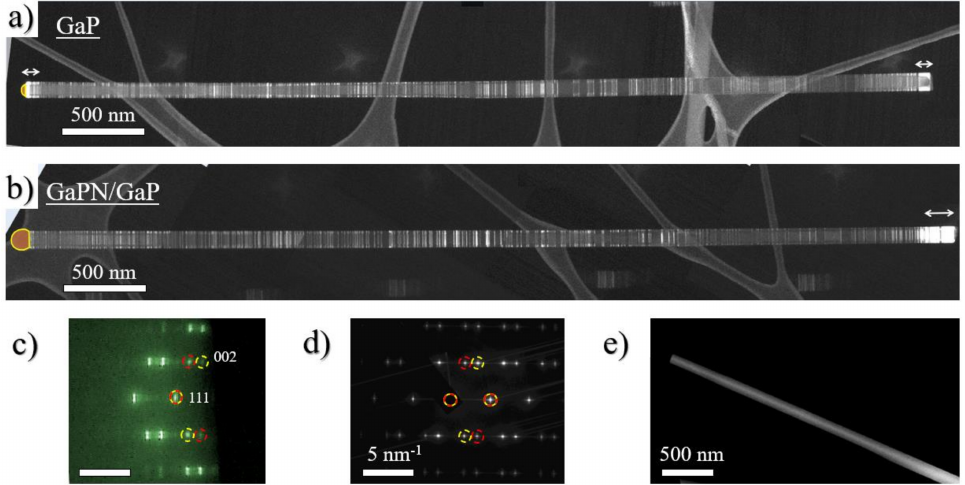
Figure 3. Dark-field TEM images of the studied ( a ) GaP reference NW, ( b ) heterostructured GaPN / GaP NW wurtzite (WZ) insertions are depicted by white arrows, ( c ) reflection high energy electron di ff raction (RHEED) pattern ( d ) selective area electron microdi ff raction pattern and ( e ) HAADF scanning transmission electron microscopy (STEM) image of heterostructured GaPN / GaP